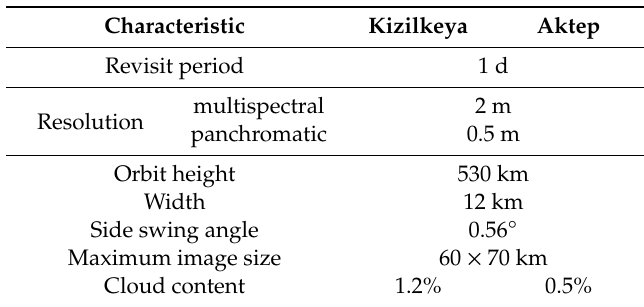
The above data are from the WGS84 coordinate system, UTM N44